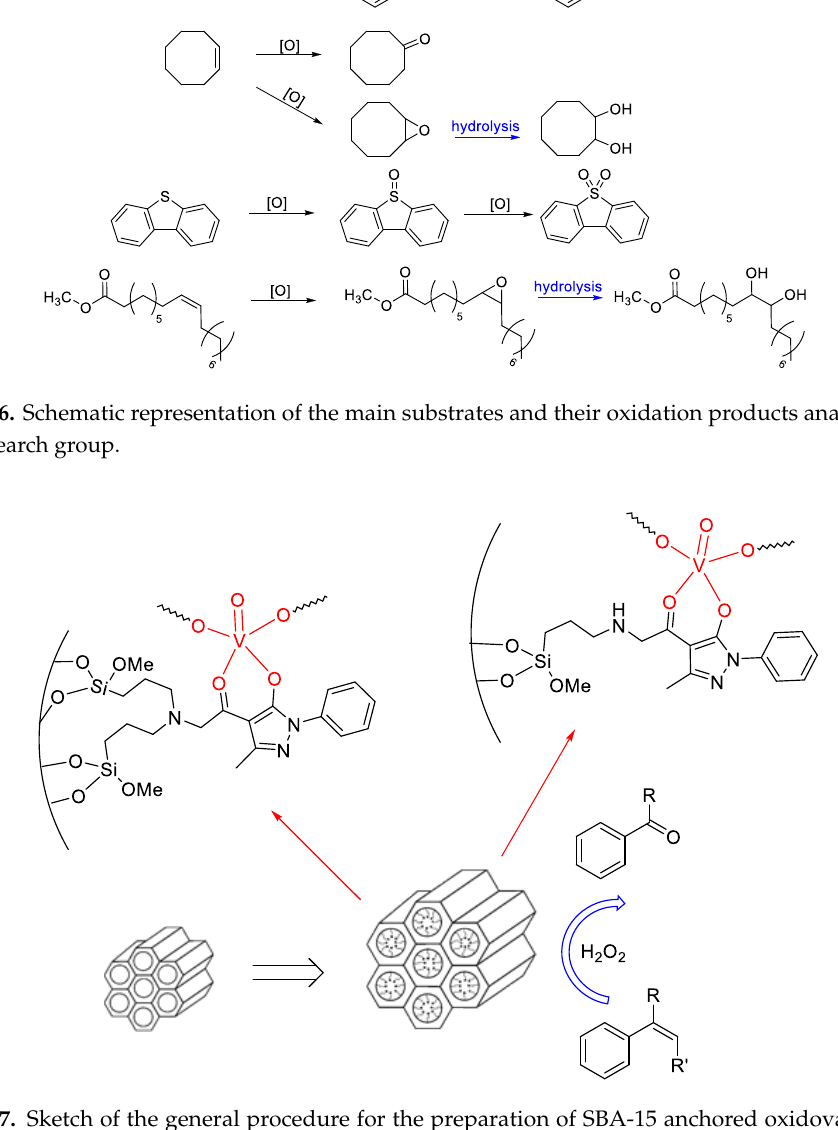
Figure 6. Schematic representation of the main substrates and their oxidation products analyzed by our research group.